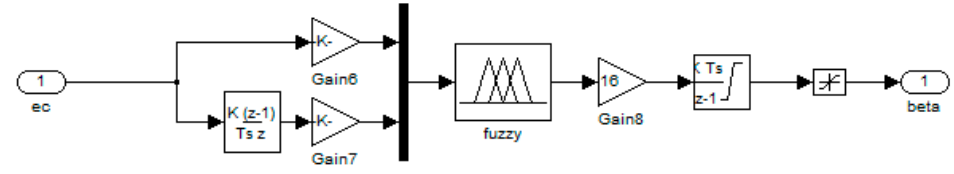
Figure 5. The Simulink model of the pitch angle controller.